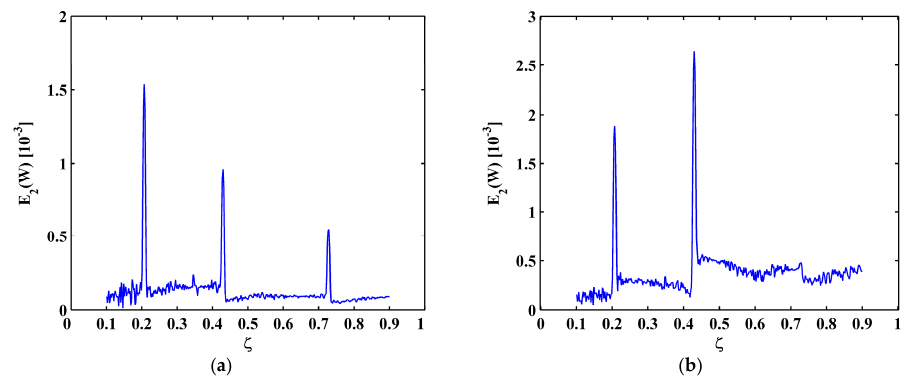
Figure 18. MRM-TKE for Scenario III ( a ) and Scenario IV ( b ).